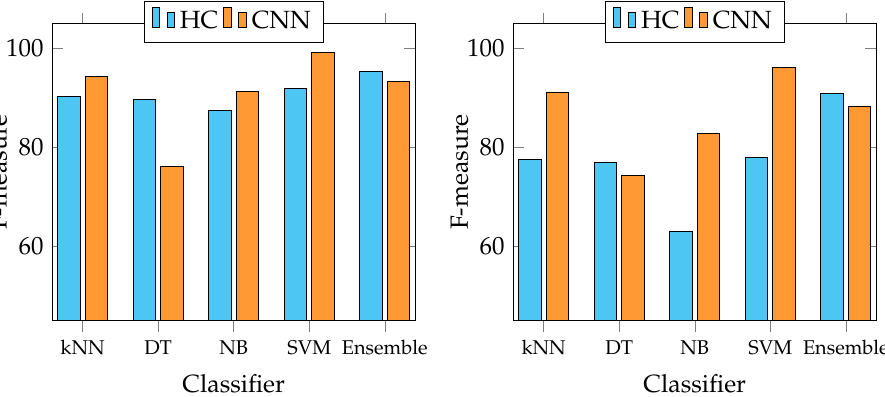
Figure 4. Average accuracy trends with the different classifiers adopted. On the left, average accuracies obtained on Canada data set; on the right, on Cagliari data set.